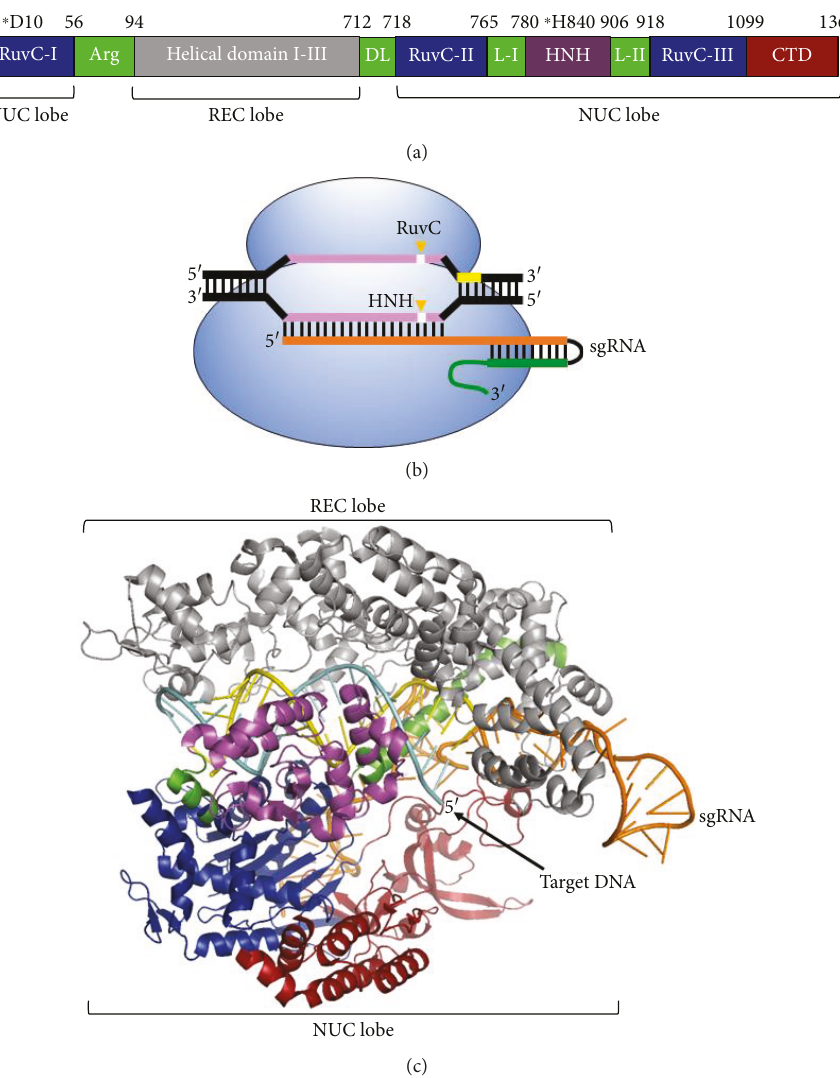
Figure 1: Overall organization, structure, and function of CRISPR-associated protein 9 (Cas9) from Streptococcus pyogenes (SpCas9). (a) Schematic representation of the domain organization of the SpCas9. Asterisks denote catalytical residues. (b) Cas9 (blue) requires a sgRNA that has a 20 bp region complementary to the target DNA. Cas9 requires two RNA components — CRISPR RNA (crRNA; orange) and transactivating RNA (tracrRNA; green). sgRNA is a chimeric RNA in which crRNA and tracrRNA are fused through a linker. PAM sequence (5 ′ -NGG-3 ′ ) is shown in yellow and is crucial for binding and cleavage. DNA cleavage occurs in two di ff erent domains: the HNH domain that cuts the target strand and RuvC domain that cleaves the nontarget strand. (c) Cartoon representation of the crystal structure of SpCas9 (PDB 4UN3). Cas9 domains are colored according to the scheme in (a). Abbreviations: Arg: arginine- rich bridge helix; DL: disordered linker; CTD: C-terminal domain; NUC: nuclease lobe; PAM: protospacer-adjacent motif; REC: recognition